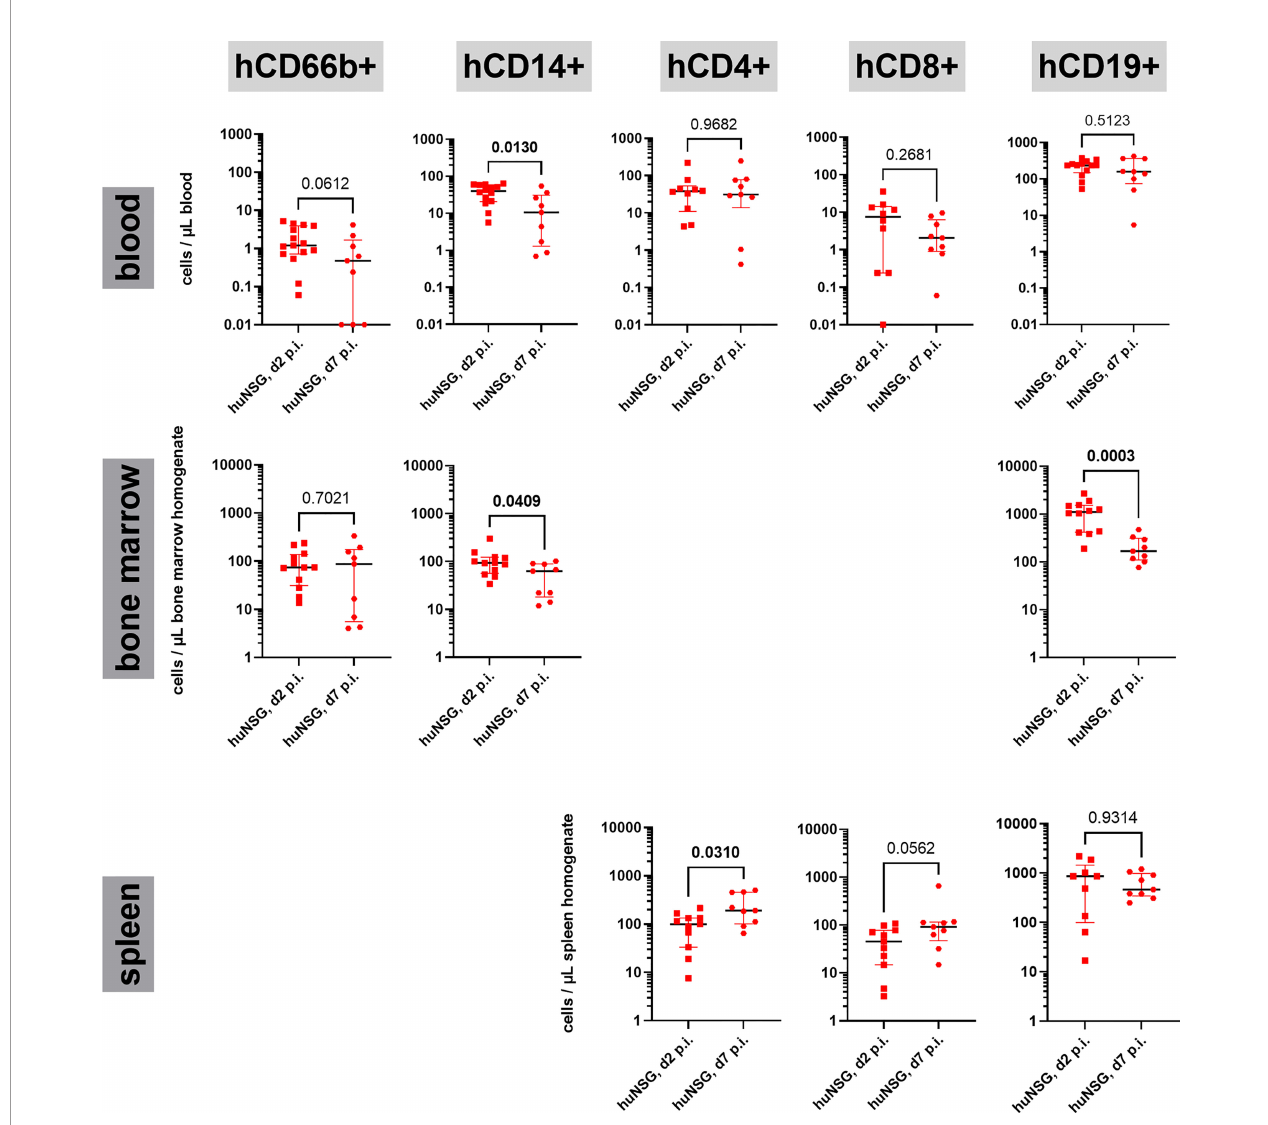
FIGURE 5 | Human immune cell lineages in blood, bone marrow and spleen during the course of thigh infection. Cells were fi rst gated for expression of hCD45 and lack of mCD45 expression, then for the respective lineage markers (hCD66b: granulocytes, hCD14: monocytes, hCD4: T helper cells, hCD8: cytotoxic T cells, CD19: B cells). The gating strategy can be found in Figure S4 . Statistical signi fi cance was tested with Mann-Whitney-test and p-values displayed (signi fi cant values (p < 0.05) are depicted as bold